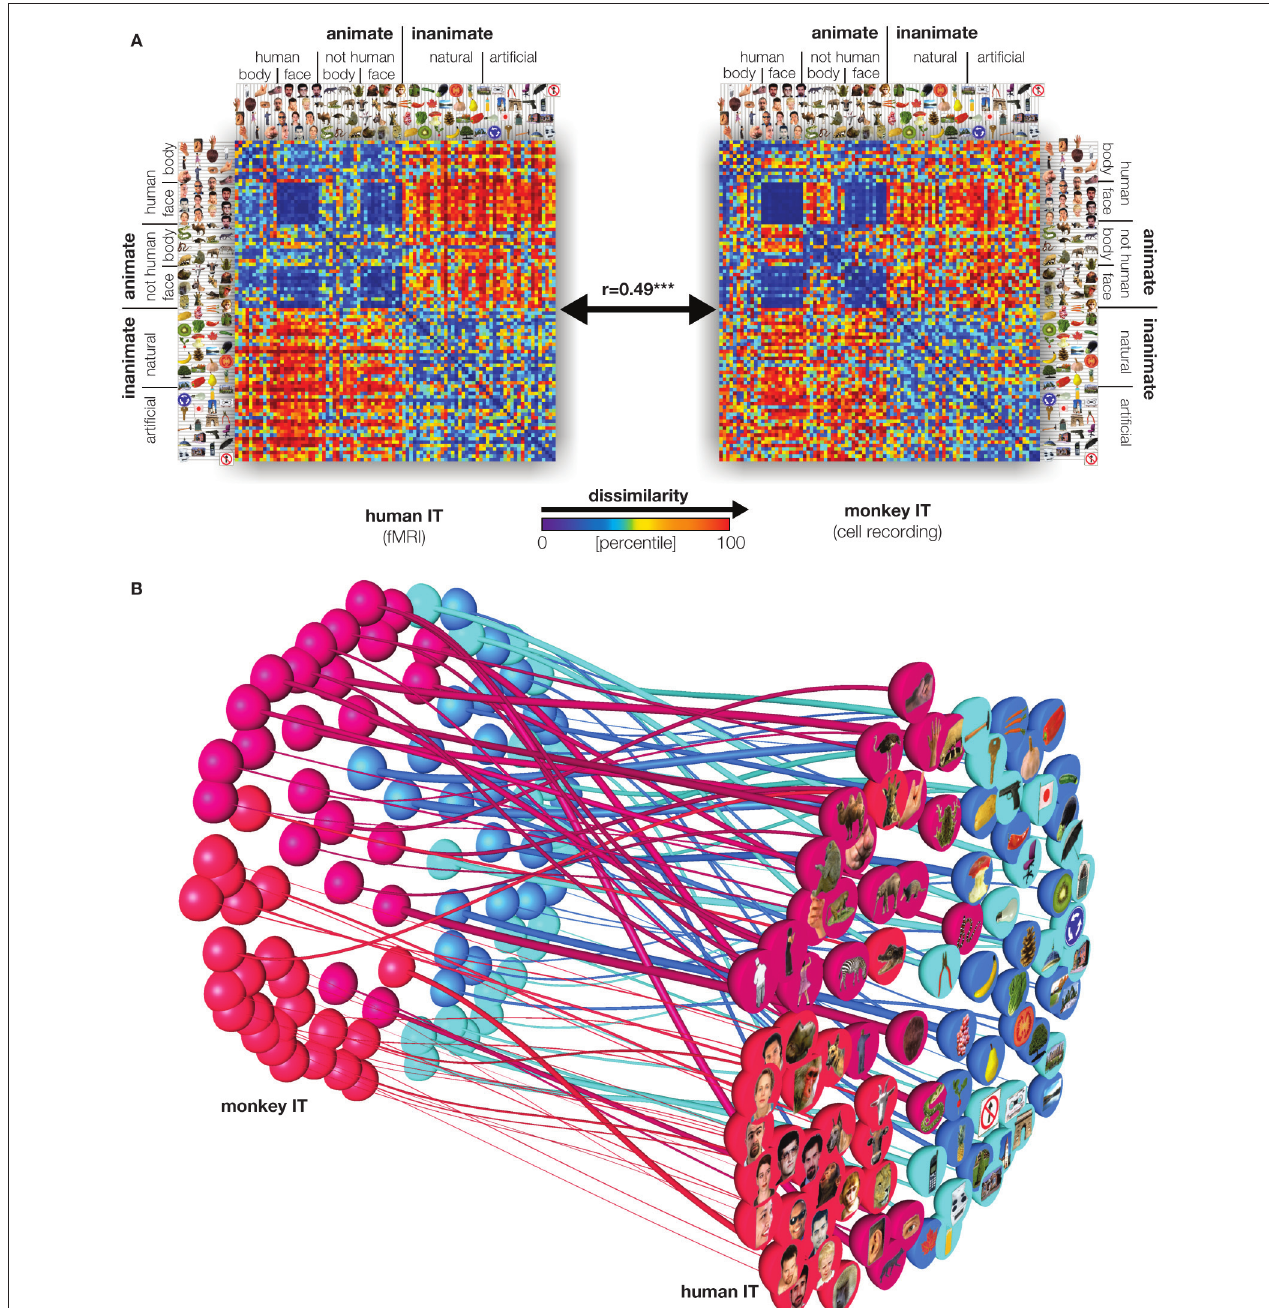
any categorical structure, but the arrangement quite cleanly divides animates and inanimates as well as faces (including human and nonhuman faces) and bodies. Colors code for conventional category: face (red), body (magenta), natural object (blue), artificial object (cyan). The connecting fibers serve to visually relate individual stimuli between the two arrangements. In addition, the thickness of the fibers can be used to visualize relational statistics. Here the thickness of each fiber reflects to what extent the corresponding stimulus is inconsistently represented in monkey and human IT. The interspecies inconsistency of stimulus i is defined as (1 − r ) 2 , where r is the correlation i i between the vectors (for human and monkey) of the 91 dissimilarities between stimulus i and the other stimuli. For details, see Kriegeskorte et al.